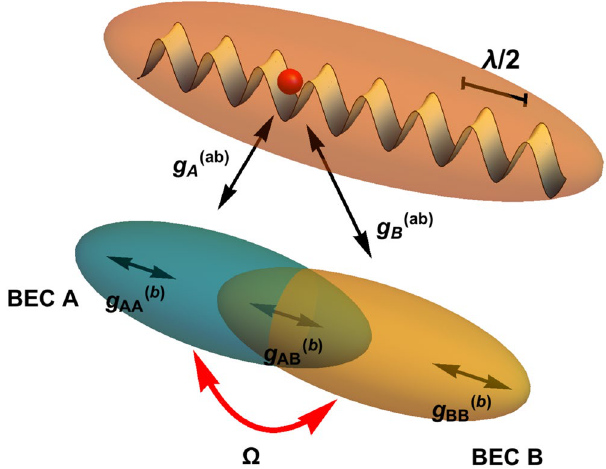
Figure 1. Scheme of the model: an impurity atom (red), trapped in a fixed site of a deep optical lattice with spacing a = λ /2 (orange), interacts with a mixture of two BECs (green and yellow) trapped in a very shallow potential. The collisional coupling strengths between pairs of atoms of the two components of the condensates and between impurities and BEC atoms are respectively g ijb ( ) and g photon Raman term